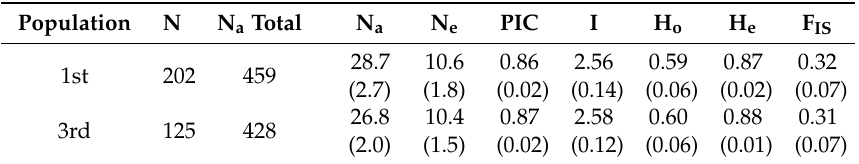
Table 4. Loci genetic diversity indices for the first and third cycle breeding populations of E. urophylla ; except for ‘N’ and ‘N a total’ the numbers for each trait in each population represent means across the 16 loci analyzed with standard deviations of these means given in